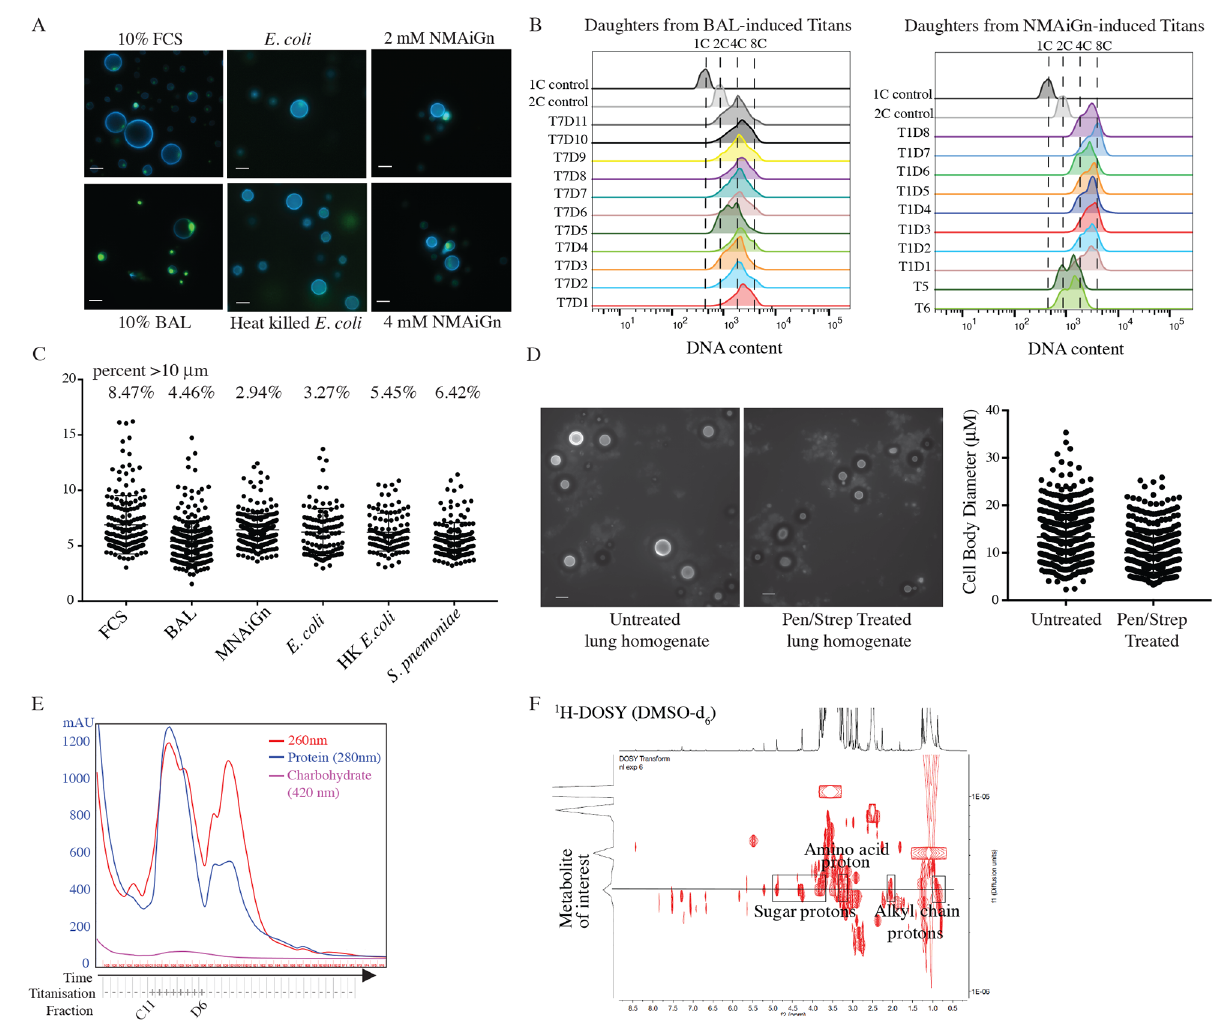
Representative micrographs are shown for live cells (CFW, SytoxGreen). Scale bar = 10 μ m. B) Daughters arising from Titan mothers induced using BAL (left, T7) or NMAiGn (right, T1, T5, T6) were isolated and allowed to proliferate for 72 hr at 30˚C on YPD agar prior to fixation and staining